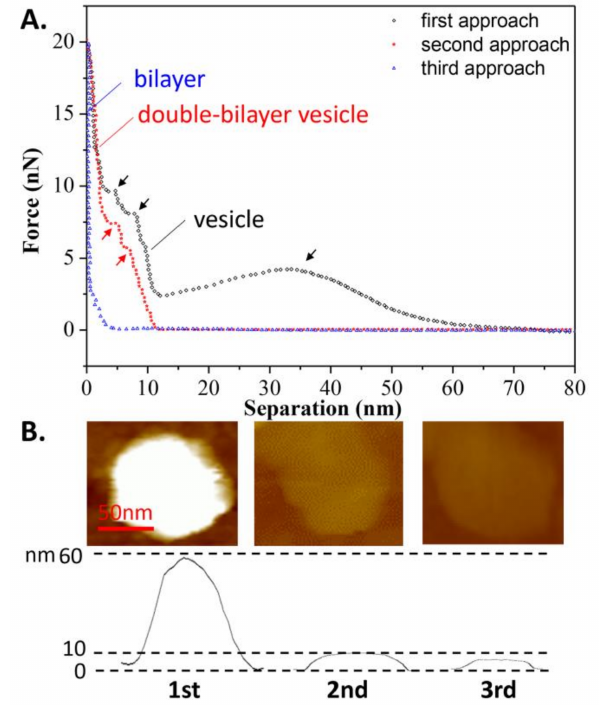
Figure 4. ( A ) Continuous approach curves on the DPPC vesicle obtained at T 1 = 60 ◦ C. Arrows refer to the jumps when the tip penetrates the bilayers; ( B ) AFM images of the vesicle prior to each